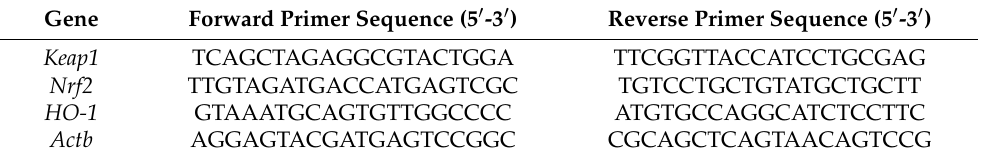
Table 1. Primers used for